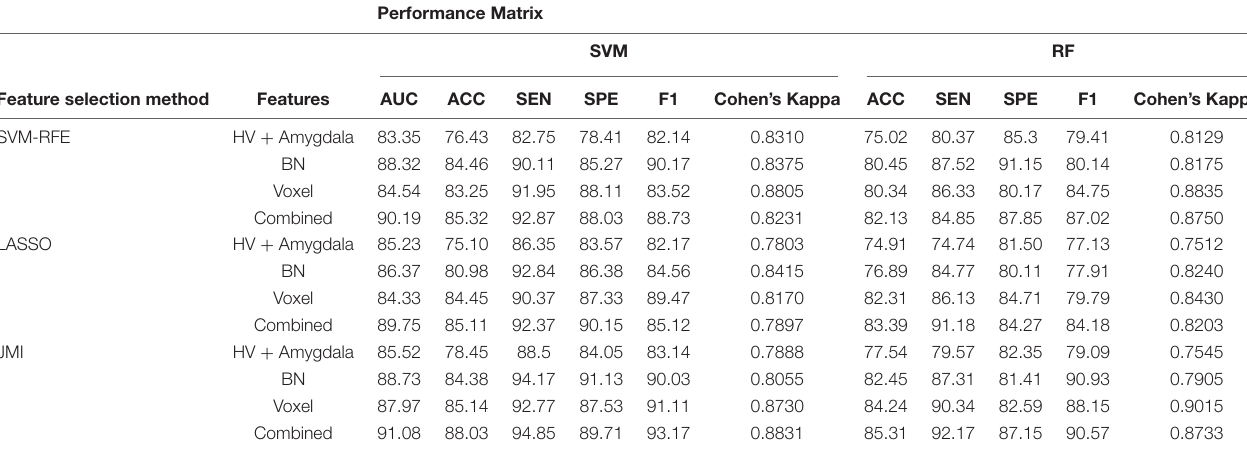
TABLE 5 | A 10-fold cross-validated binary classification performance for stable MCI (MCIs) vs. converted MCI (MCIc) groups using SVM and RF classifiers. Performance